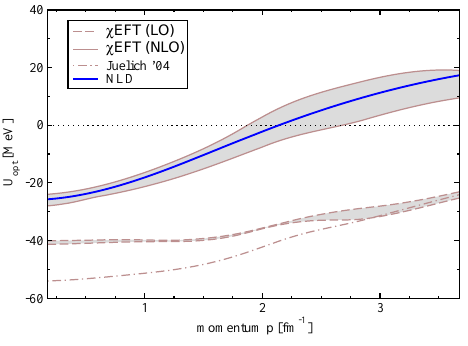
Table 1. Λ -, Σ - and Ξ -regulators for σ - ( Λ σ ), ω -( Λ ω ) 1 , 2 Figure 3. Optical potential of Λ -hyperons versus their ) vertices in units of GeV. In the & ρ -hyperon ( Λ ρ 1 , 2 momentum at various densities of symmetric nuclear ) are relevant cases for Σ and Ξ the isospin cut-offs ( Λ ρ 1 , 2 matter. The NLD calculations at three Fermi-momenta for the charged particles only. For the Σ -hyperon (thick-solid, thick-dashed and thick-dot-dashed curves) different cut-offs values are used for Σ − (upper line) and as indicated are compared to the χ -EFT calculations in for Σ + (bottom line). NLO.